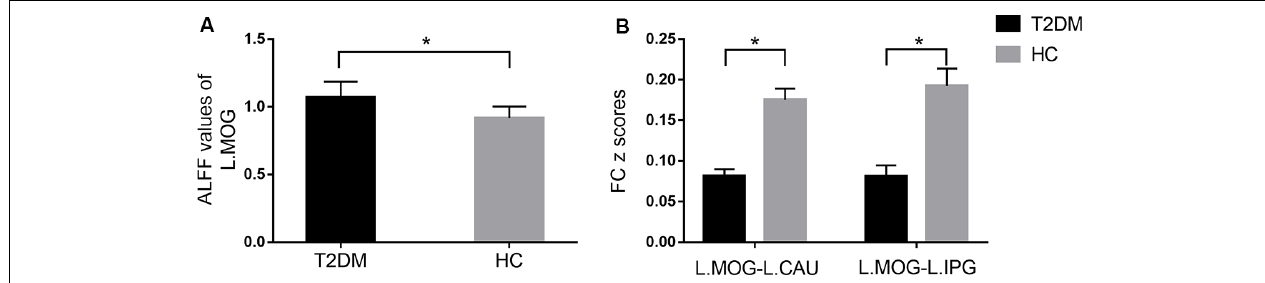
FIGURE 2 | Comparison of ALFF (A) and FC (B) between the type 2 diabetes mellitus (T2DM) and healthy controls (HC) groups (two-sample t -test). * p < 0.05 (corrected with Gaussian random-field theory). Error bars define the SEM. R, right; L, left; MOG, middle occipital gyrus; CN, caudate nucleus; IPG, inferior parietal gyrus.